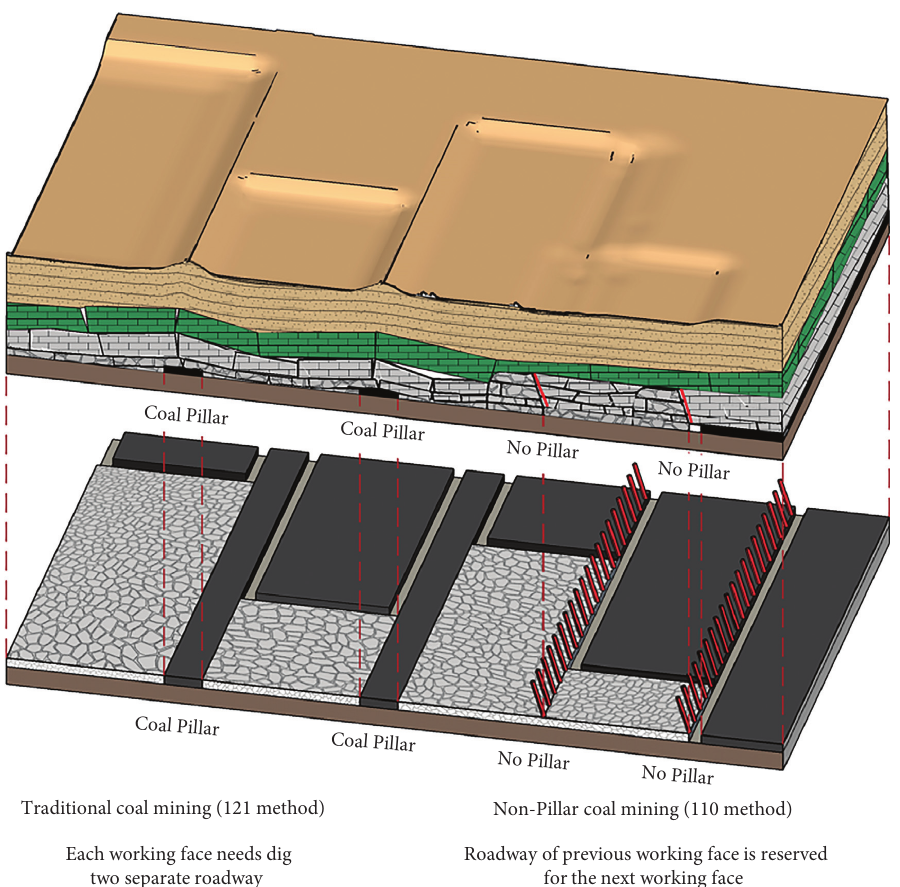
Figure 1: Schematic diagram of traditional coal mining (121-method, left half of the figure) and nonpillar mining with GERRC (110- method, right half of the